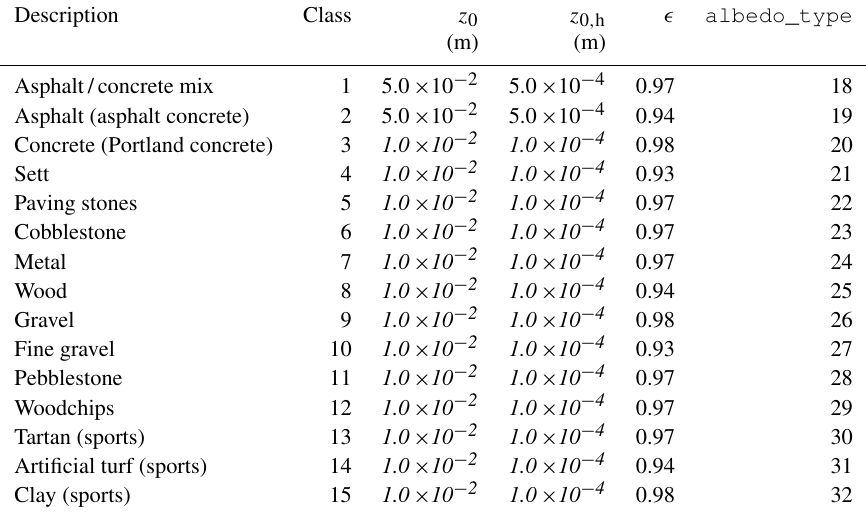
Table A3. Pavement classification parameters according to pavement_type based on OpenStreetMaps. Thermal conductivity and heat capacity settings of the subsurface pavement layers are given in Table A4. Italic values are preliminary. z 0 and z 0 , h are the roughness lengths for momentum and heat, respectively, and (cid:15) is the surface emissivity.